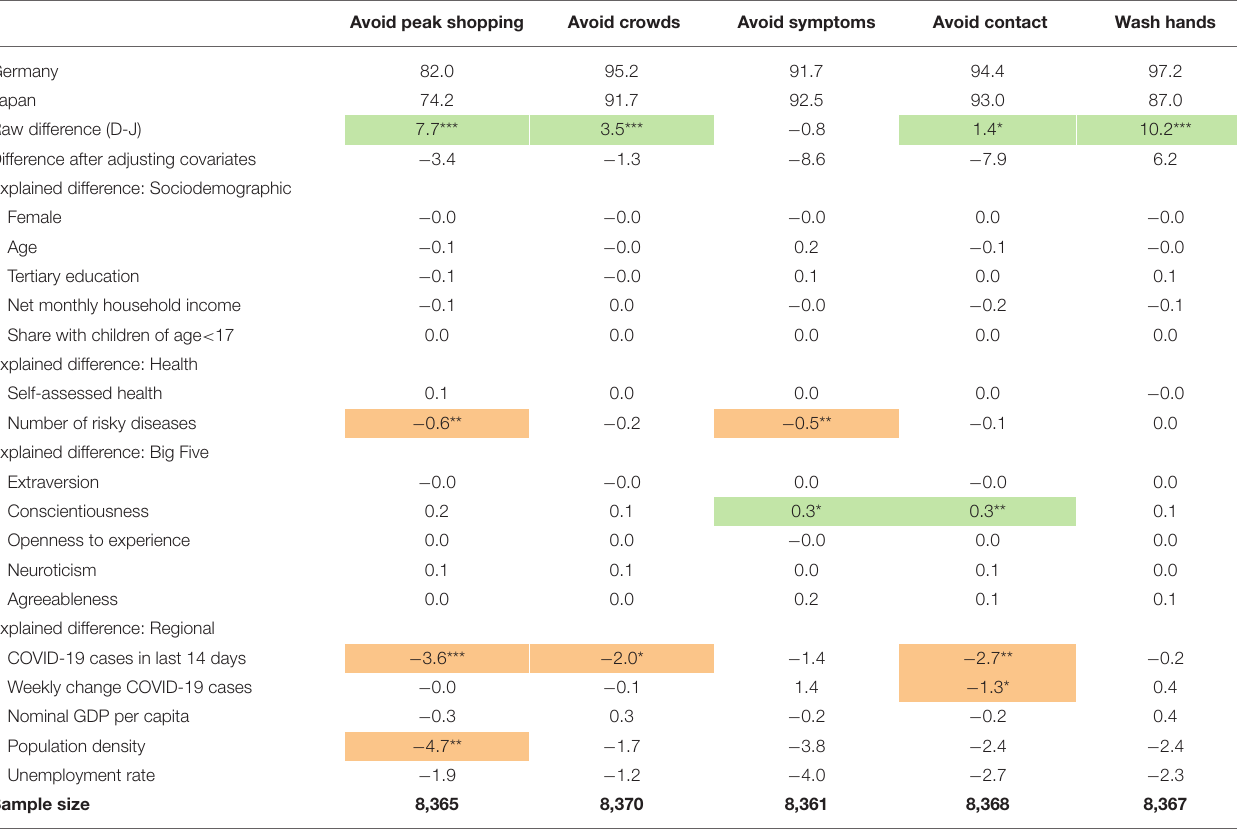
Table 4.2 | Contribution of differential endowments to differential attitudes and behaviors (2). Avoid peak shopping Avoid crowds Avoid symptoms Avoid